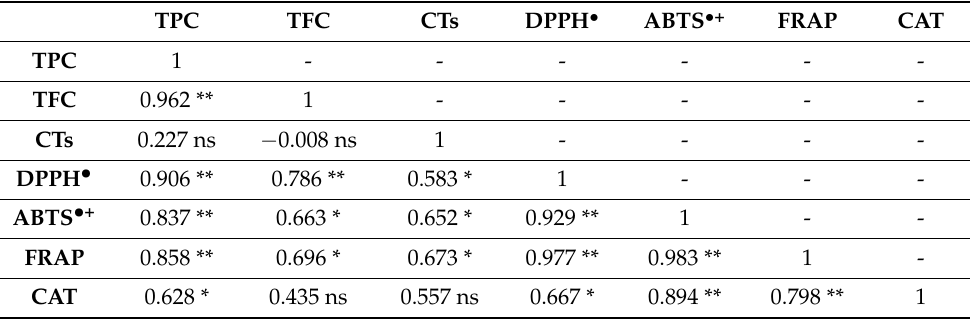
Table 4. Pearson’s correlation coefficients (r) for some of the investigated parameters of the three extracts of A. arboreum leaves.